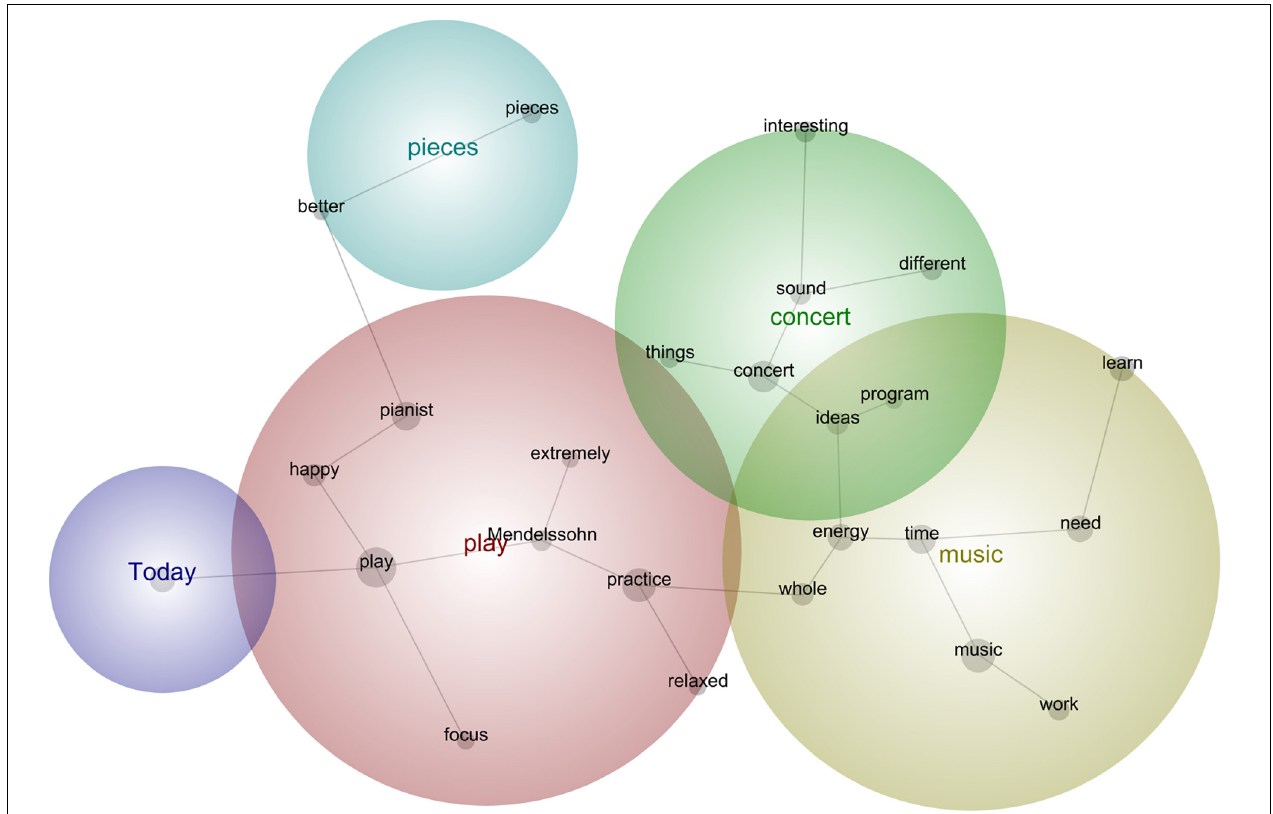
FIGURE 9 | Leximancer concept map for Concert